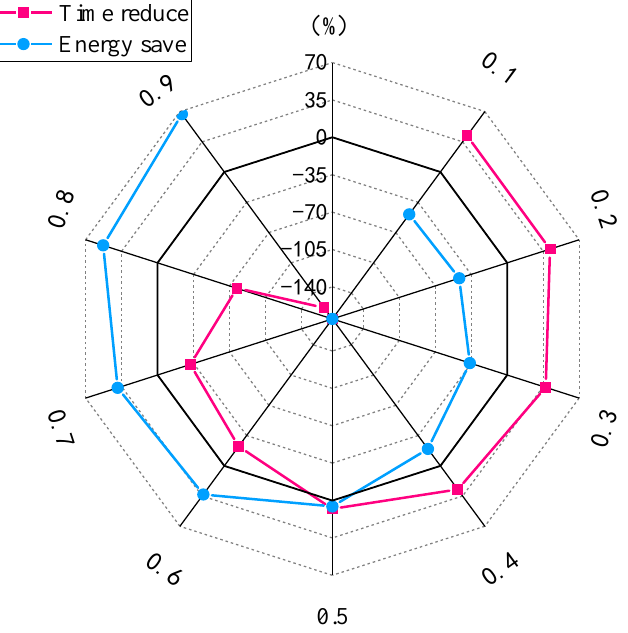
Figure 10. Comparison between charging method and CCCV charging method for different weight factors.